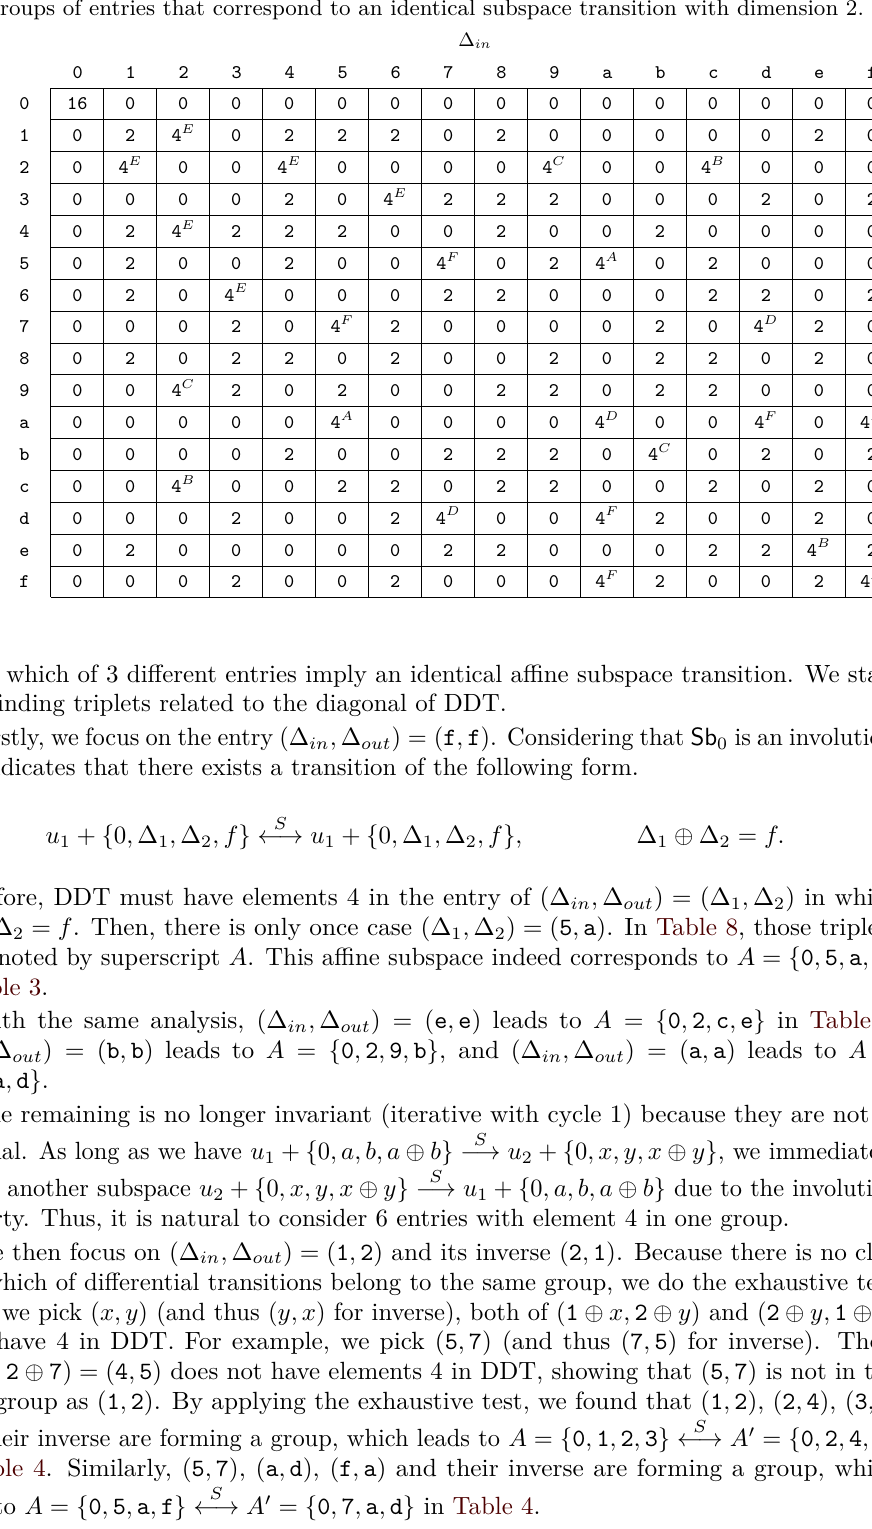
Table 8: Differential Distribution Table (DDT) of Sb 0 used in Midori64 . Superscript alphabets show groups of entries that correspond to an identical subspace transition with dimension